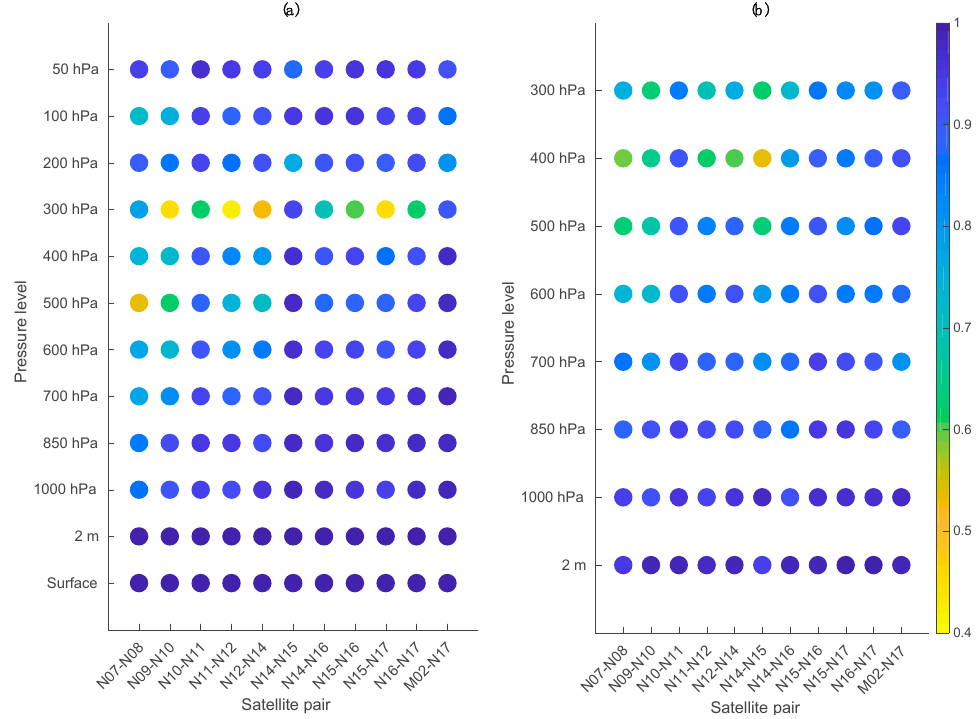
Figure 2. Correlation coefficients by standard atmospheric pressure level of eleven satellite pairs for ( a ) temperature and ( b ) specific humidity.